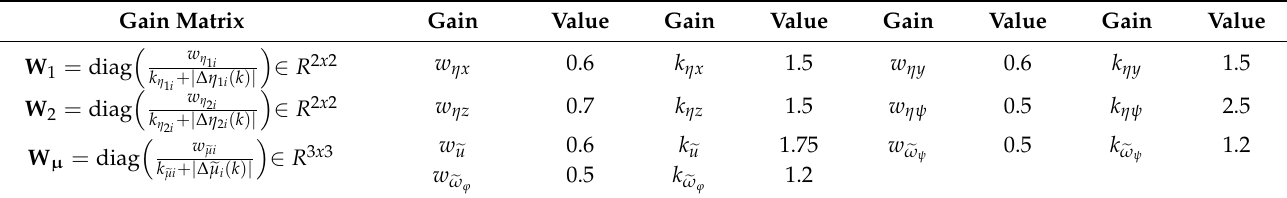
Table 3. Proposed gain values for the control